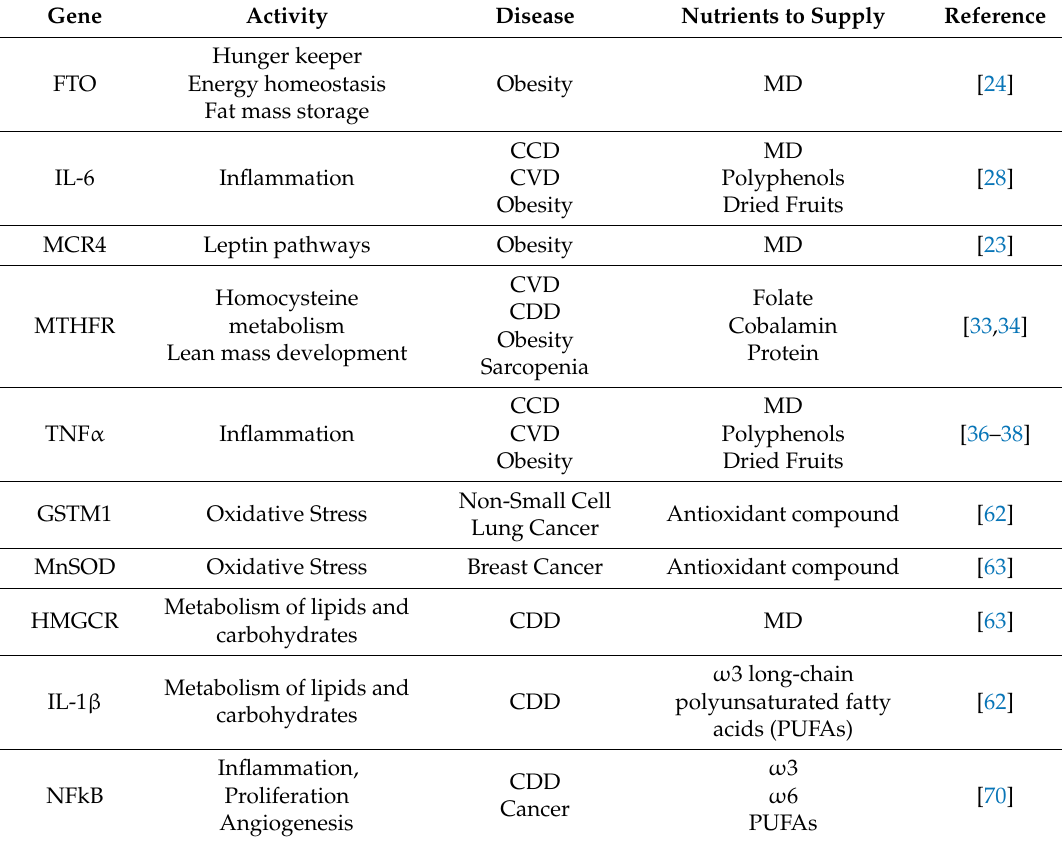
Table 1. Gene polymorphism and nutrients to supply for personalized